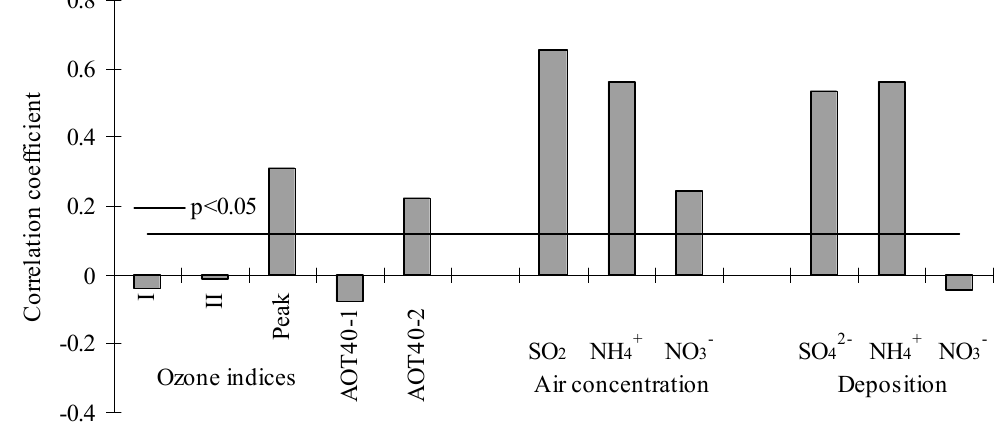
FIGURE 3. Correlation coefficients of mean defoliation of pine stands and considered pollution variables in Lithuanian national parks (I – mean annual value; II – mean value for vegetative period; AOT40-1 for vegetation; AOT40-2 for forest)